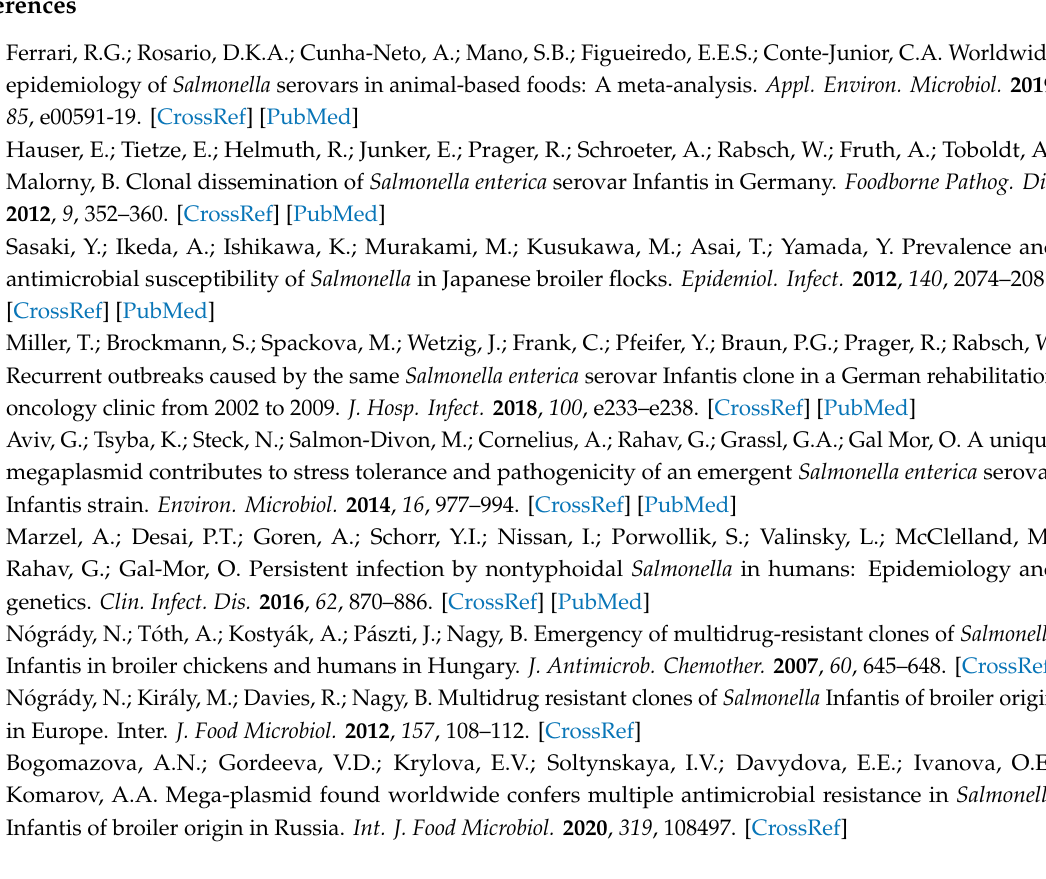
Table S1: Resistome prediction for seven colistin-resistant S. Infantis isolates analyzed by the Comprehensive Antibiotic Resistance Database, Table S2: Genes encoding virulence factors from genomes of seven colistin-resistant S. Infantis isolates detected using virulence factor database, Table S3: The CRISPR / Cas loci of seven colistin-resistant S. Infantis isolates detected using CRISPRCasFinder program, Table S4: Primers used in this study, Figure S1: Distribution of the core and accessory genes within pan-genome, Figure S2: Visualization of pan-genome constructed using Roary based on the core and accessory genes showing phylogenetic relatedness of the isolates by blue (present) and white (absent) fragments. At the bottom of the figure the percentage of isolates that have each gene is shown, Figure S3: Pan-genome analysis: pan and core genome curves (A); frequency distribution of gene families within genomes (B); the number of new genes added to each genome (C); the COG and KEGG distribution of the representative proteins in the core, accessory, and unique genome (D and